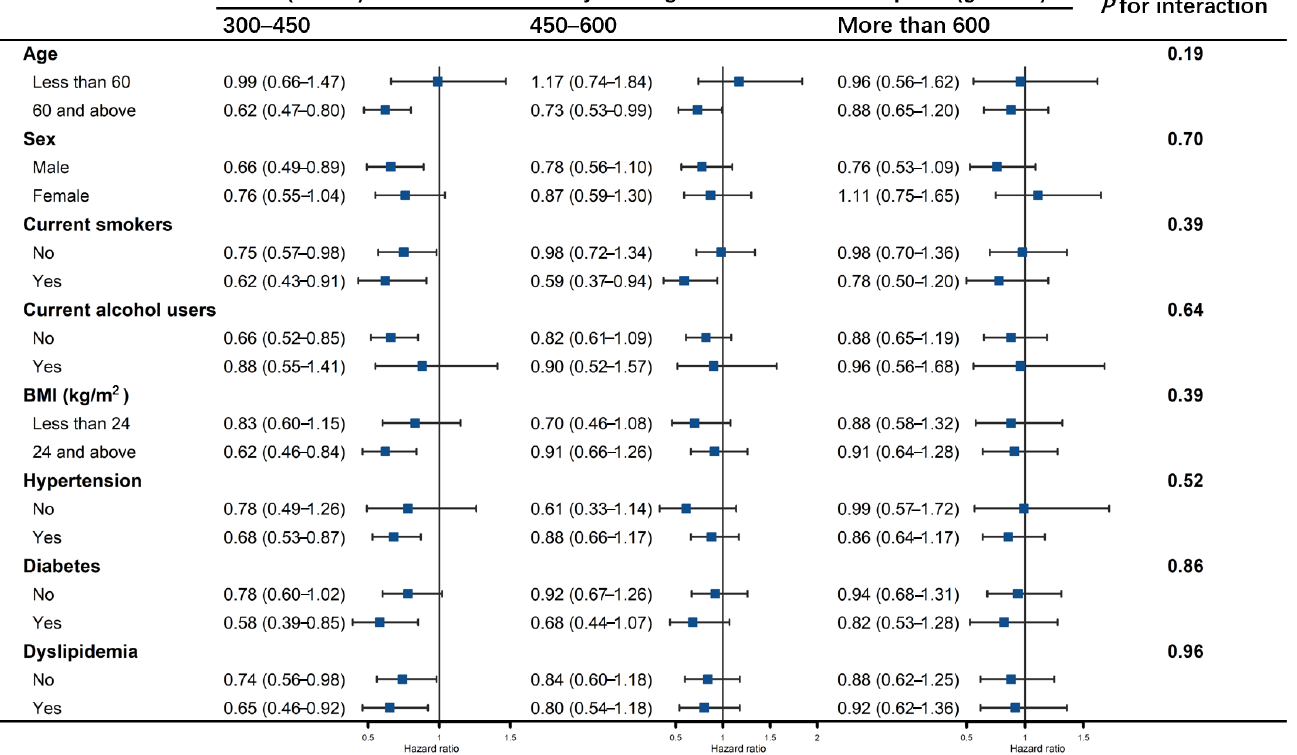
Figure 4. Association of fish consumption (g/week) between the risk of ischemic stroke by subgroups of age, sex, smoking status, alcohol drinking status, BMI groups, history of hypertension, diabetes, and dyslipidemia. The model was adjusted for age, sex, educational levels, marital status, retirement status, smoking status, alcohol drinking status, physical activity levels, sleep qualities, obesity status, dietary energy intakes, consumption of fruit, vegetables, peanuts, wholegrains, processed and unprocessed meats, bean products, salt and oil, histories of chronic diseases, including hypertension, CHD, diabetes, CKD, dyslipidemia, HUA, HHcy, COPD, chronic bronchitis and asthma (the same as covariates in Model 3). Each subgroup analysis was adjusted for all the covariates listed above except itself.